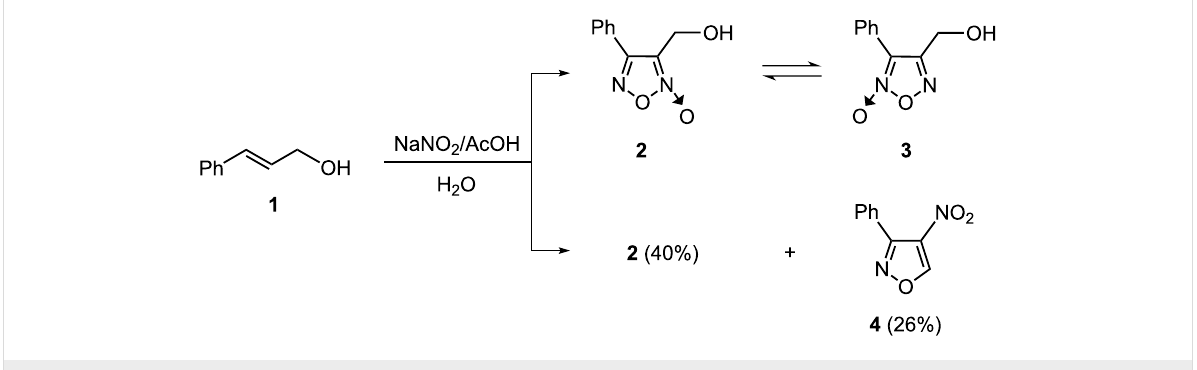
Figure 1: The crystal structure of compound 4 . Ellipsoids correspond to 50% probability levels.